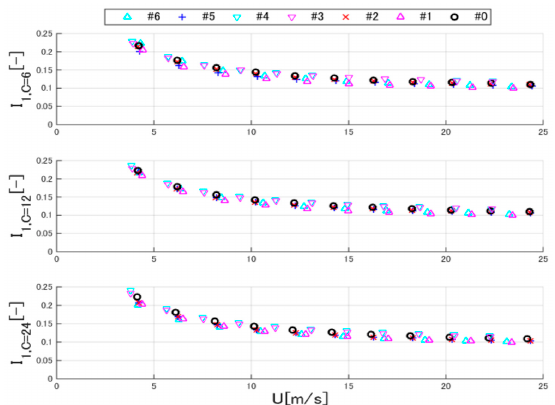
Figure 2. Longitudinal turbulence intensity to wind speed at each hub centre.